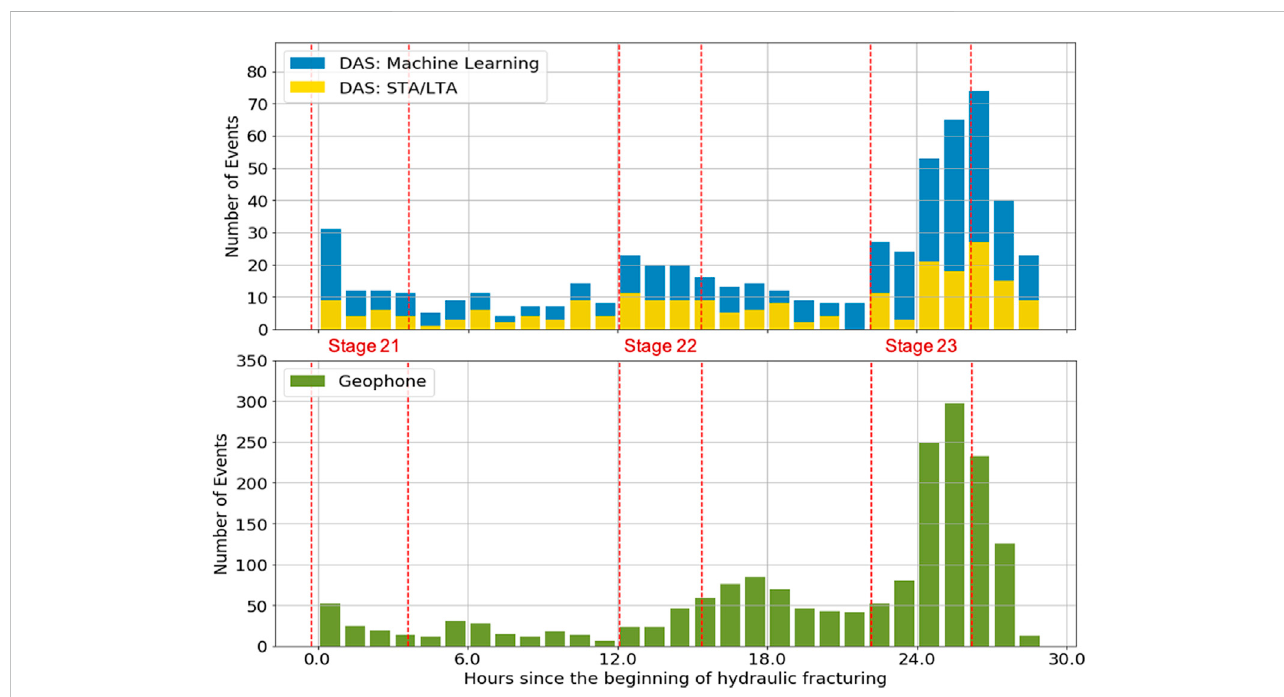
FIGURE 8 Casestudy 1:Comparison ofevent histograms from DAS and3C geophonefor three stages.CNN (blue) signi fi cantly extends theDAScatalog compared toSTA/LTA(yellow).AlthoughDASdetectsfewereventsthanthegeophones(green),thereisgoodgeneralagreementinthedistributionofeventsversustime.